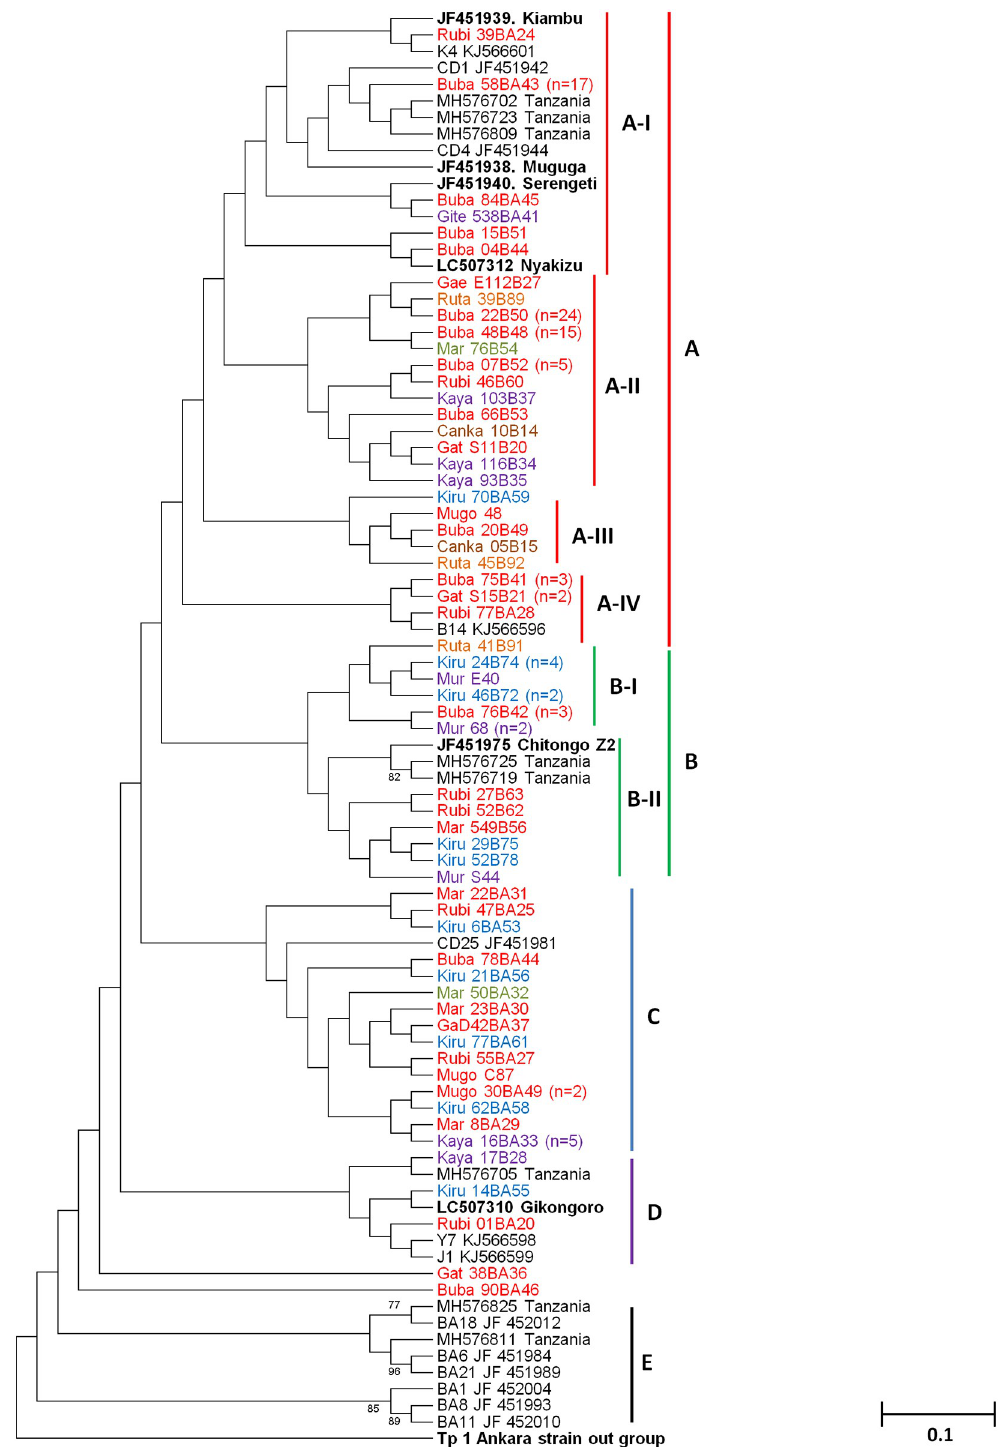
Fig 3. Neighbour joining phylogenetic tree for Theileria parva CTL Tp1. The tree was generated from 432 bp nucleotide sequences using MEGA ver. 6 with 1000 bootstrap replicates as a confidence level. For sequences that shared 100% identity, a single sequence was used to represent the group on the phylogenetic tree. Samples from the Northern, Southern, Eastern, Western, Central and North Eastern regions are given in blue, black, orange, yellow, purple and brown colour codes,